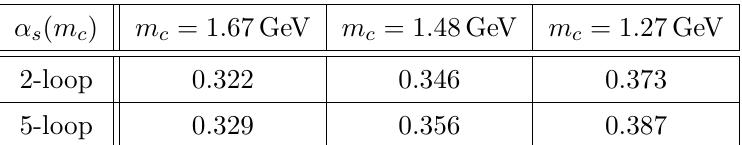
Table 2 . Numerical values of the strong coupling α s evaluated at different scales and loop order, obtained using the RunDec package